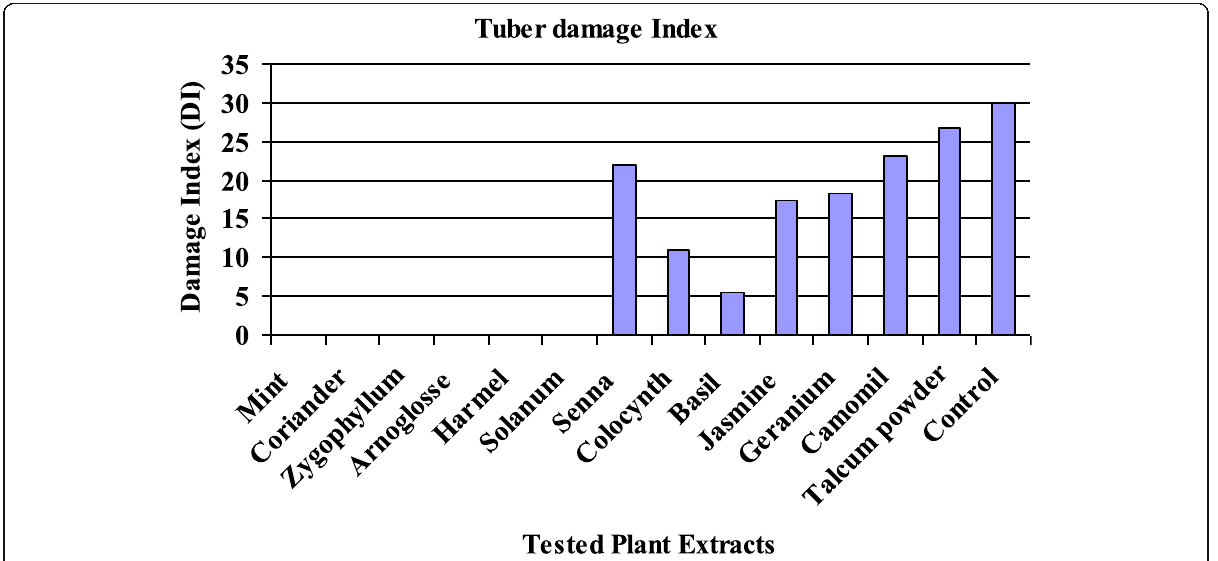
Fig. 2 Evidence of damage for potato tubers treated with different botanical